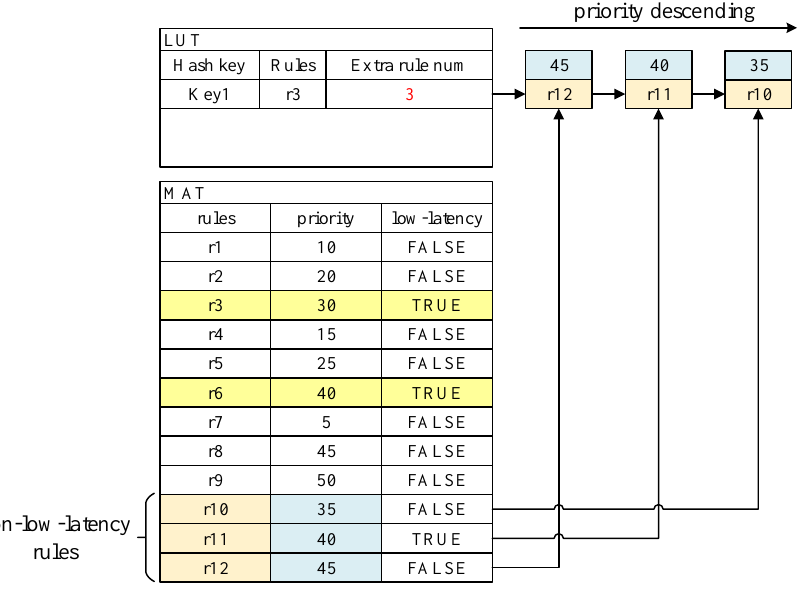
Figure 6. LUT updating when non-low-latency rules are added in the